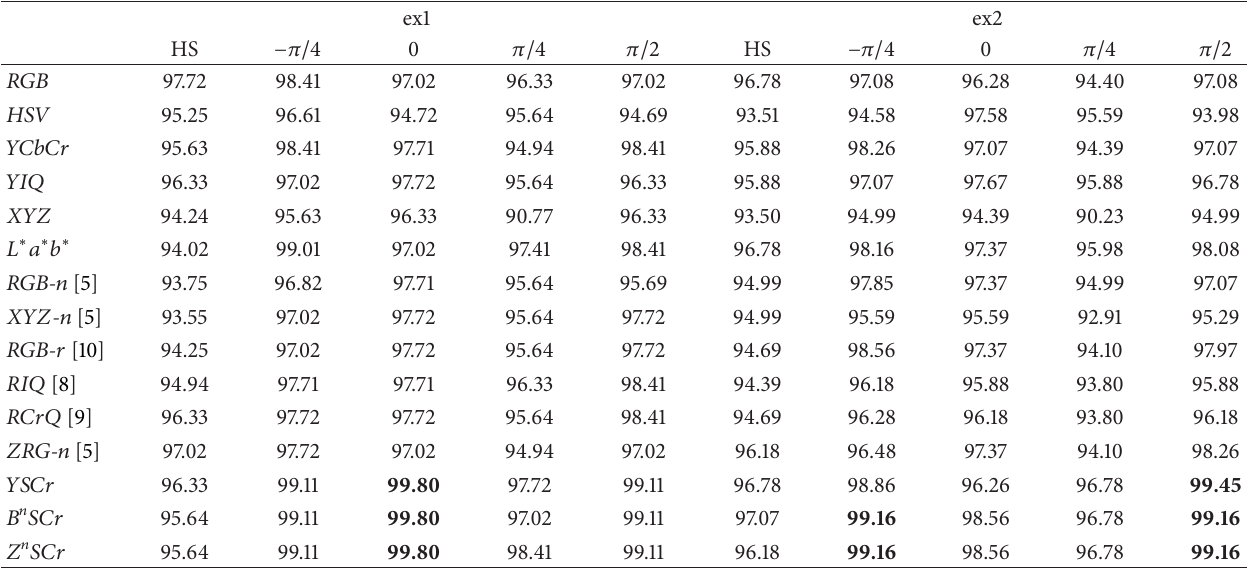
Table 2: Performance comparison in different hybrid color spaces of LCSPT-ELM face recognition algorithm: the AR database. ex1